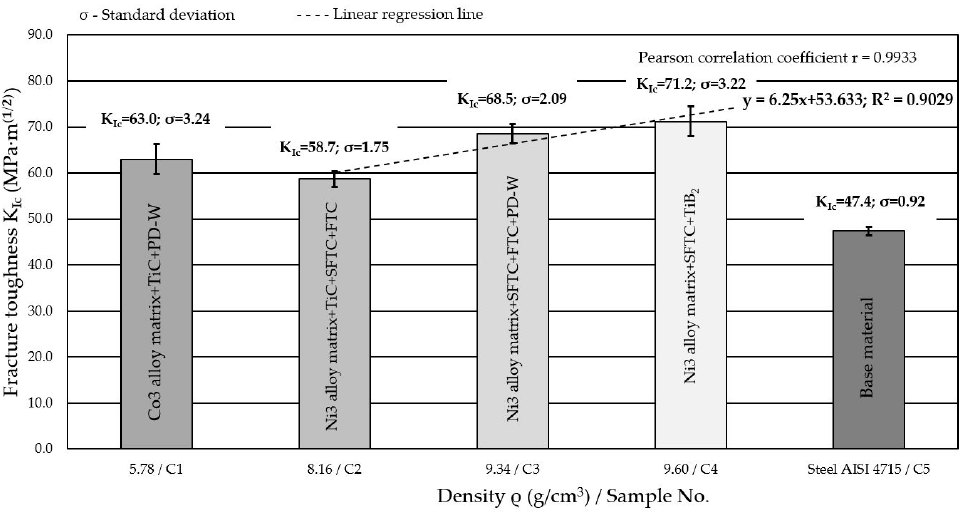
Figure 13. Influence of composite layer density on the critical value of the stress intensity factor K Ic .